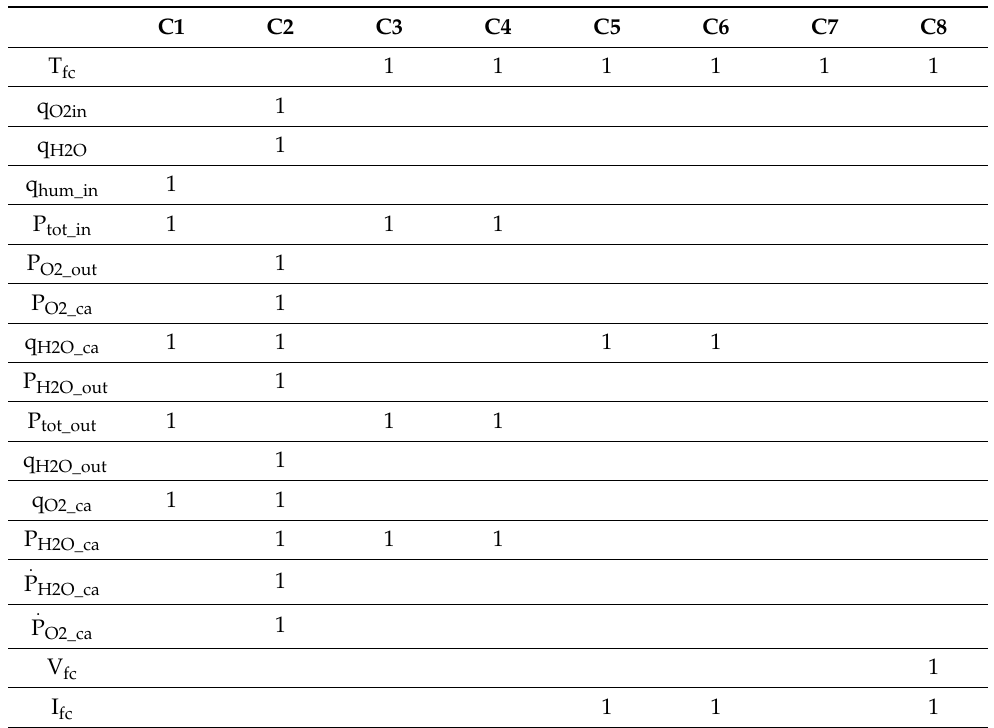
Table 1. Incidence matrix of the structural